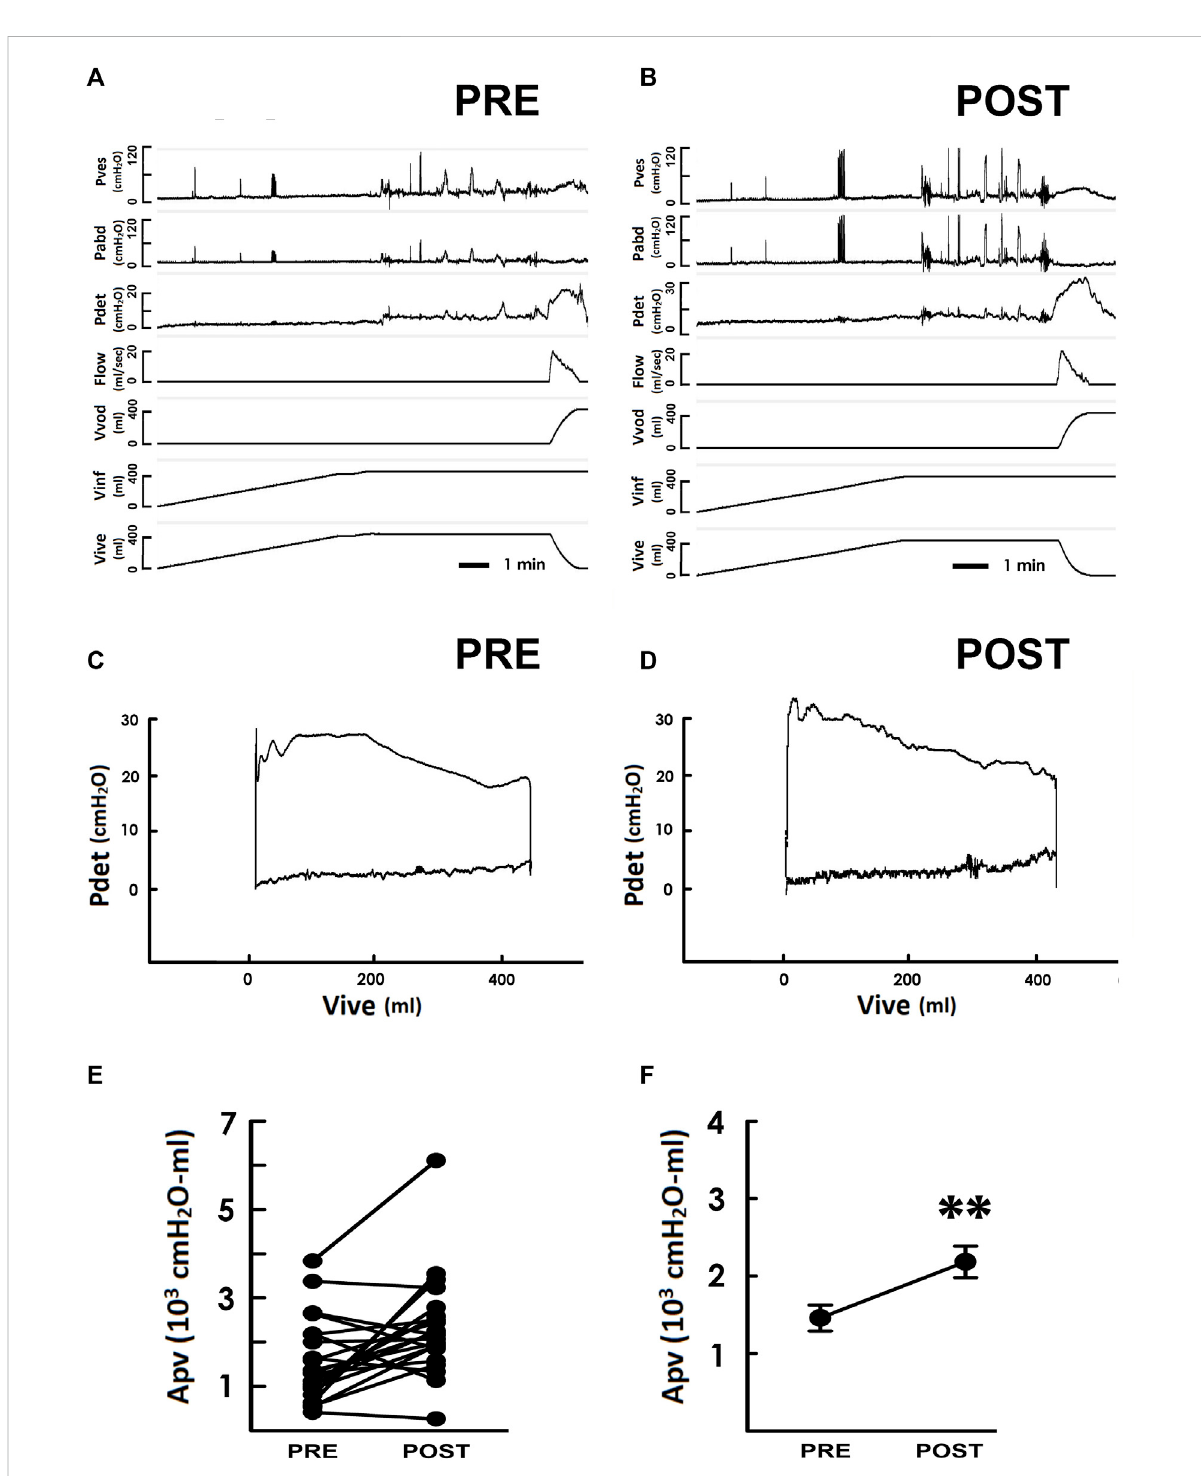
FIGURE 3 Pressure- fl ow/-volume analyses in response to the TOT surgery. (A,B) representative cystometry of a SUI patient measured pre- and postoperatively(PREandPOST,respectively).Pvesisthevesicalpressure,Pabdabdominalpressure,Pdetdetrusorpressure,Flowurethral fl ow,Vvod voided volume, Vinf infused volume, and Vive is intra-vesical volume. (C,D) Pressure-volume analyses measured before and after the TOT surgery, respectively. (E) the loop-enclosed area (Apv) of each SUI patient measured pre- and post-operatively. (F) summarized Apv of SUI patients before and after the TOT surgery (** p < 0.01 vs. PRE; N =